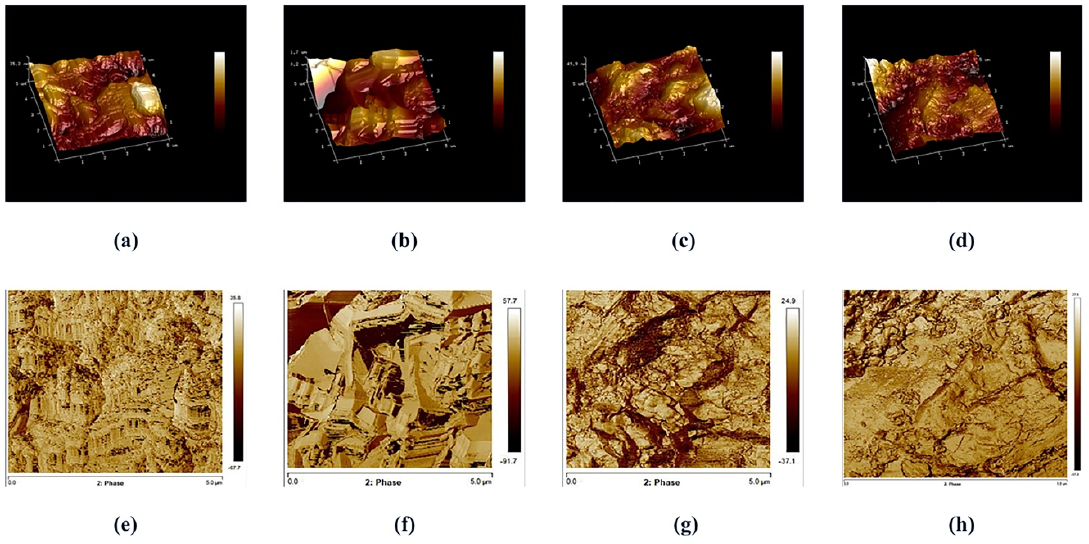
Figure 3. AFM 3D and 2D images of the surface roughness in representative specimens of the LIC: ( a , e ) control group; ( b , f ) etching; ( c , g ) plasma O2; ( d , h ) plasma argon.